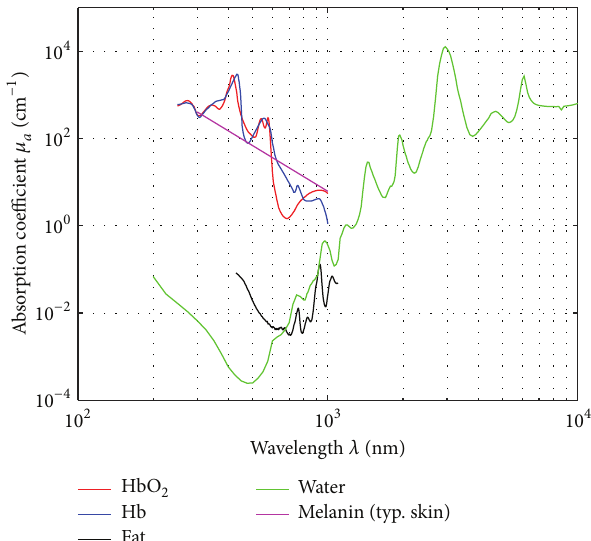
Figure 1: Absorption spectra of chromophores (absorbers) present in biological tissues. Data and equations for generating these plots